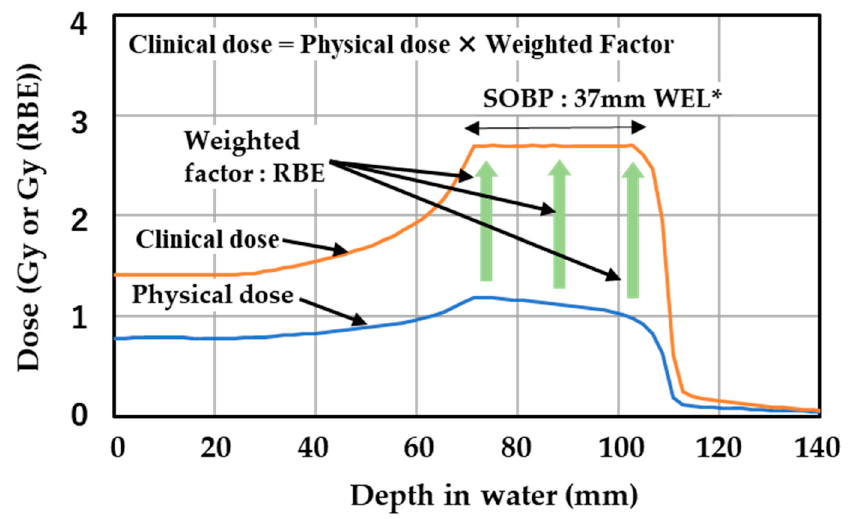
Figure 1. An example of clinical dose (Gy (RBE)), physical dose (Gy), weighted factor, and SOBP in carbon ion radiotherapy produced by the treatment planning system. The size and depth of the SOBP and the value of clinical dose are determined by the cancer type, the tumor size and location, the location of important organs, the size of margin for irradiation, and other conditions. WEL*: water equivalent length.